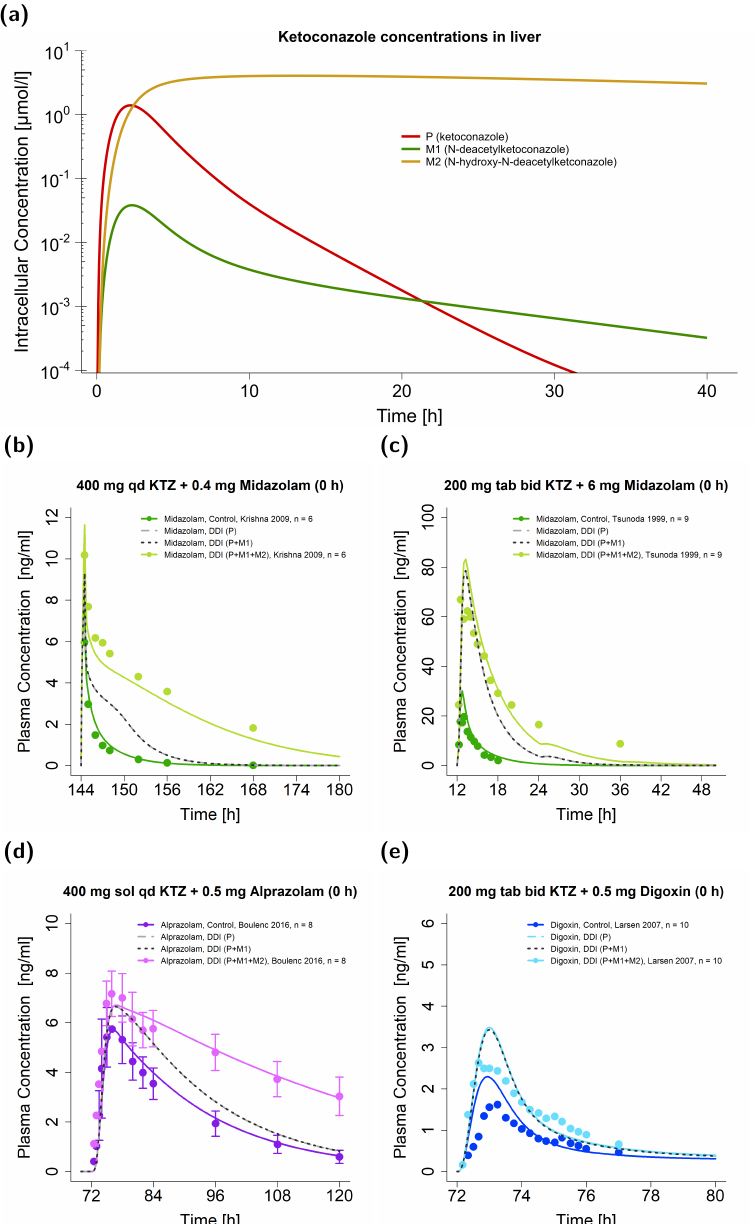
Figure 5. Ketoconazole DDI model simulations without a dosing time gap between victim and perpetrator. Predicted intracellular concentrations in liver cells are illustrated for ketoconazole and its metabolites (M1 and M2) on a semi-logarithmic scale ( a ). Predicted compared to observed plasma concentration-time profiles are illustrated for DDIs with the victim drugs midazolam ( b , c ), alprazolam ( d ), and digoxin ( e ) [15,53–55]. Illustrated are DDI predictions (i) with the parent alone (P) (long dashed line in grey), (ii) with the parent and M1 (P + M1) (dashed line in black), and (iii) with the parent and both metabolites (P + M1 + M2) (solid line in a brighter colored shade) alongside their respective reference profile (solid line in a darker colored shade). Corresponding observed data are shown as dots (arithmetic mean ± standard deviation (if available)). Detailed information on the study protocols is provided in Table S3.7 in the Supplementary Materials.